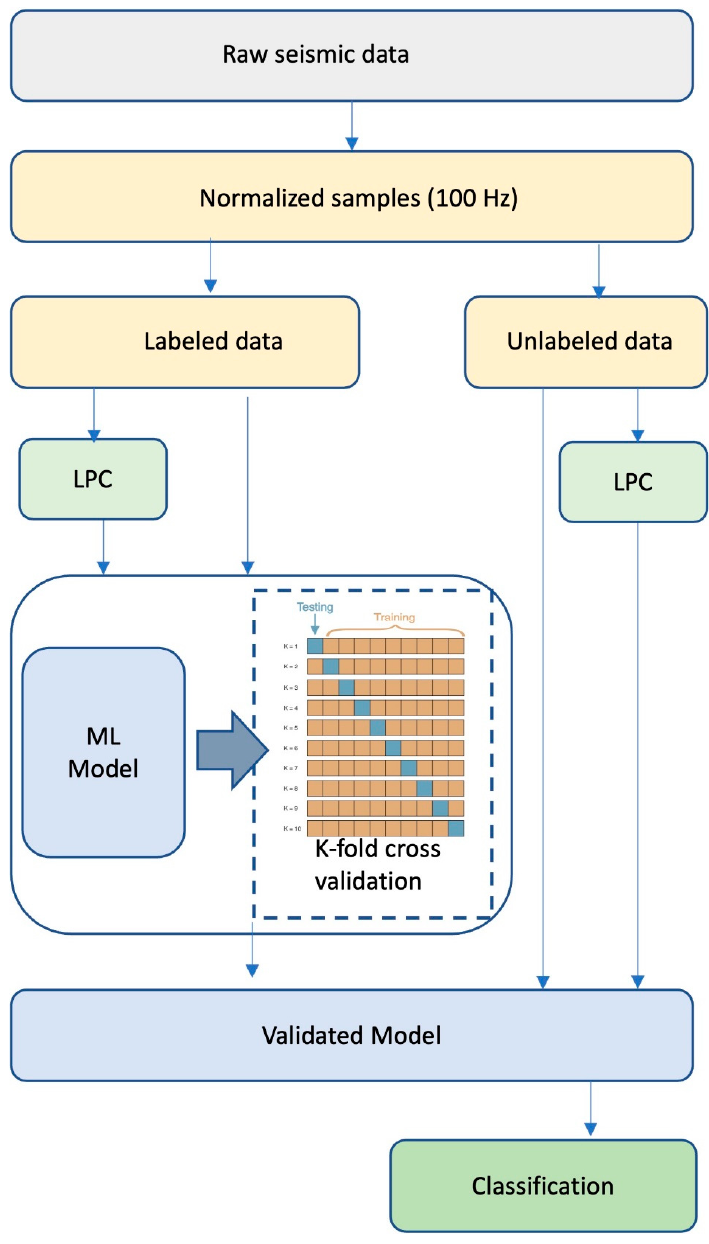
Figure 3. Workflow of the ML process.